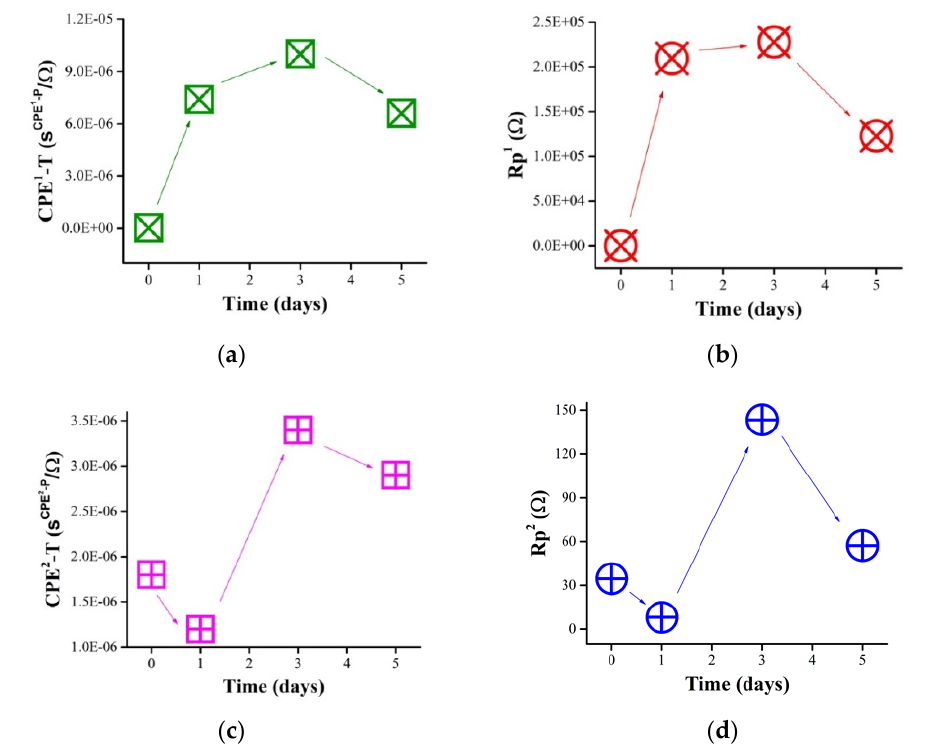
Figure 9. Evolution of CPE-T ( a , c ) and R p ( b , d ) parameters during cell growth on sample TN.